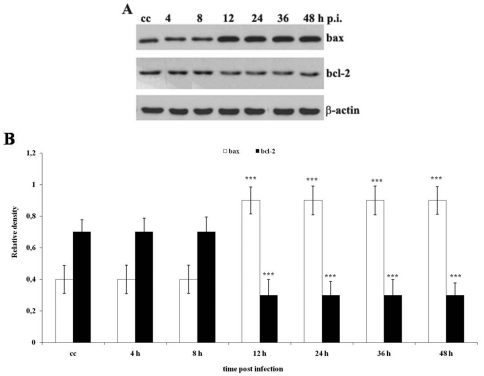
CCoV-II infection modulates the gene regulation of bax and bcl-2.(A) To perform Northern blot assay, RNA was extracted from mock-infected (lanes cc, control cells) and infected cells at the indicated times, electrophoresed and hybridized with a labelled probe as described under Material and Methods. β-actin was used as loading control. Blot is representative of three separate experiments. (B) Densitometric analysis of blots relative to bax and bcl-2. The bars represent the mean ± SEM of the results from three separate experiments. Significant differences between CCoV-II-infected cells and control cells are indicated by probability P. ***P <0.001.